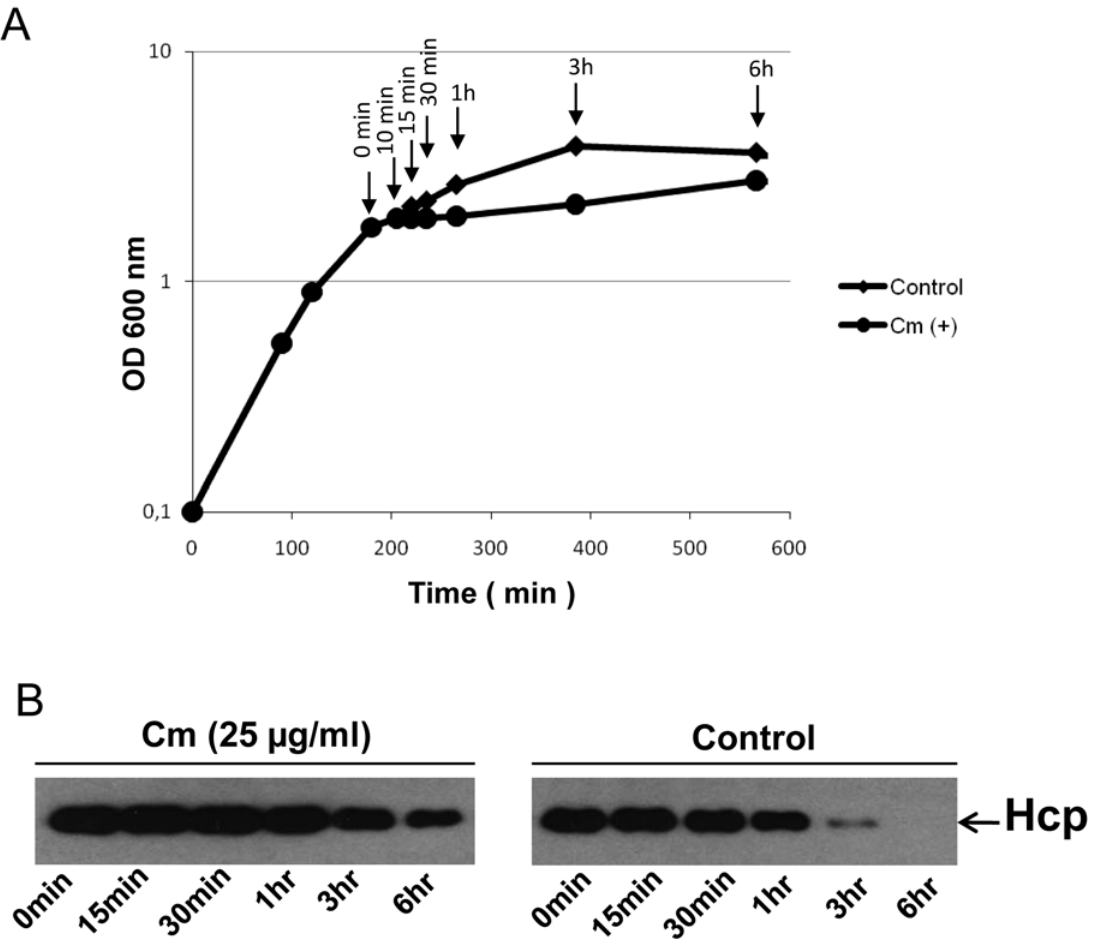
Figure 2. Analysis of Hcp stability in V.cholerae O1 wild type strain A1552. (A) The growth curve and time of sampling for Hcp analyses of V. cholerae wild type strain A1552 with and without chloramphenicol (Cm) treatment. The bacterial cells were grown to OD 2.0 and 25 m g/ml Cm was added. Arrows indicate the time points of sampling for immunoblot analysis after the addition of Cm. (B) Immunoblot analysis of the stability of Hcp in V. cholerae wild type strain A1552. The samples were taken at different time points after the addition of Cm (for the test sample). For the control experiment, the samples were taken at different time points during normal growth of bacteria. The vertical arrows show the time points when the samples were taken.